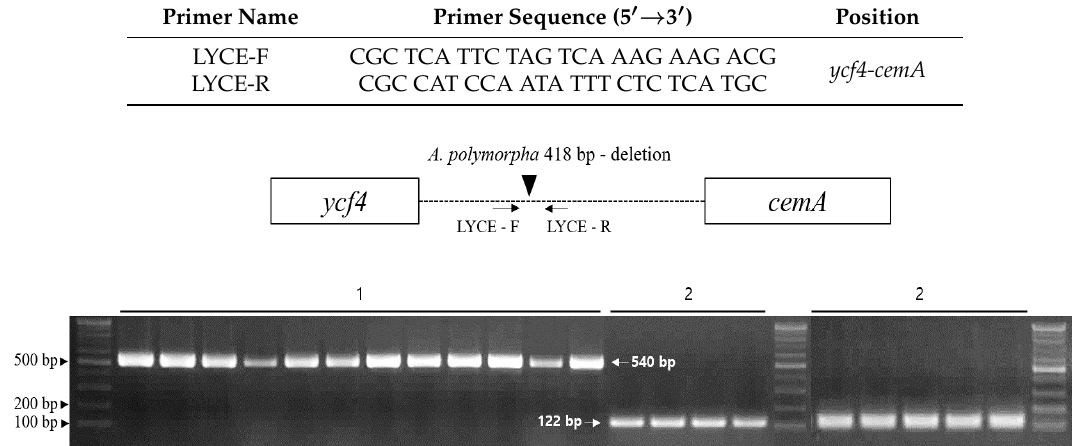
Figure 6. PCR amplification of the LYCE indel marker in 21 A. polymorpha and L. officinale accessions. 1, L. officinale ; 2, A.